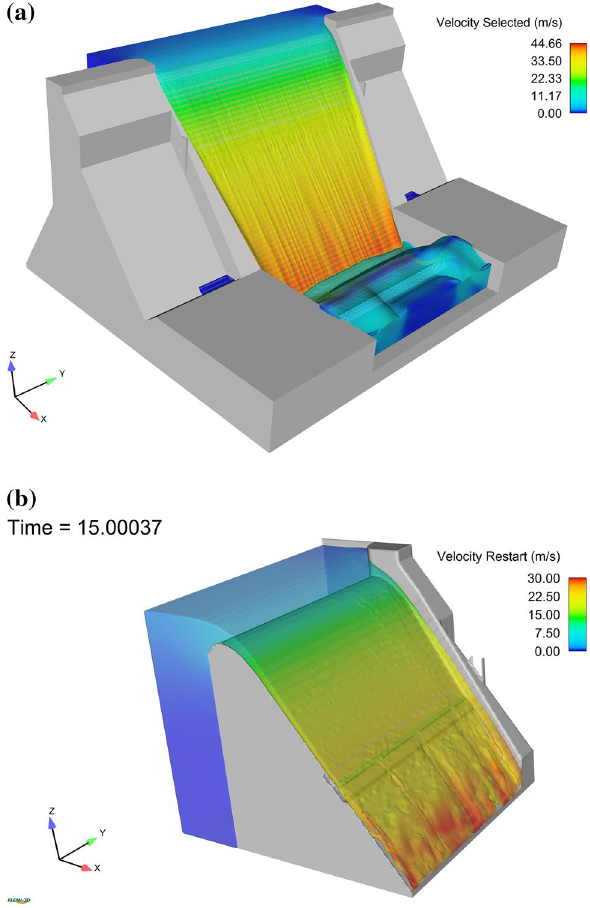
Fig. 4 Water surface velocity profiles ( Q = 5223 m 3 /s): a one-phase flow model, b two-phase flow